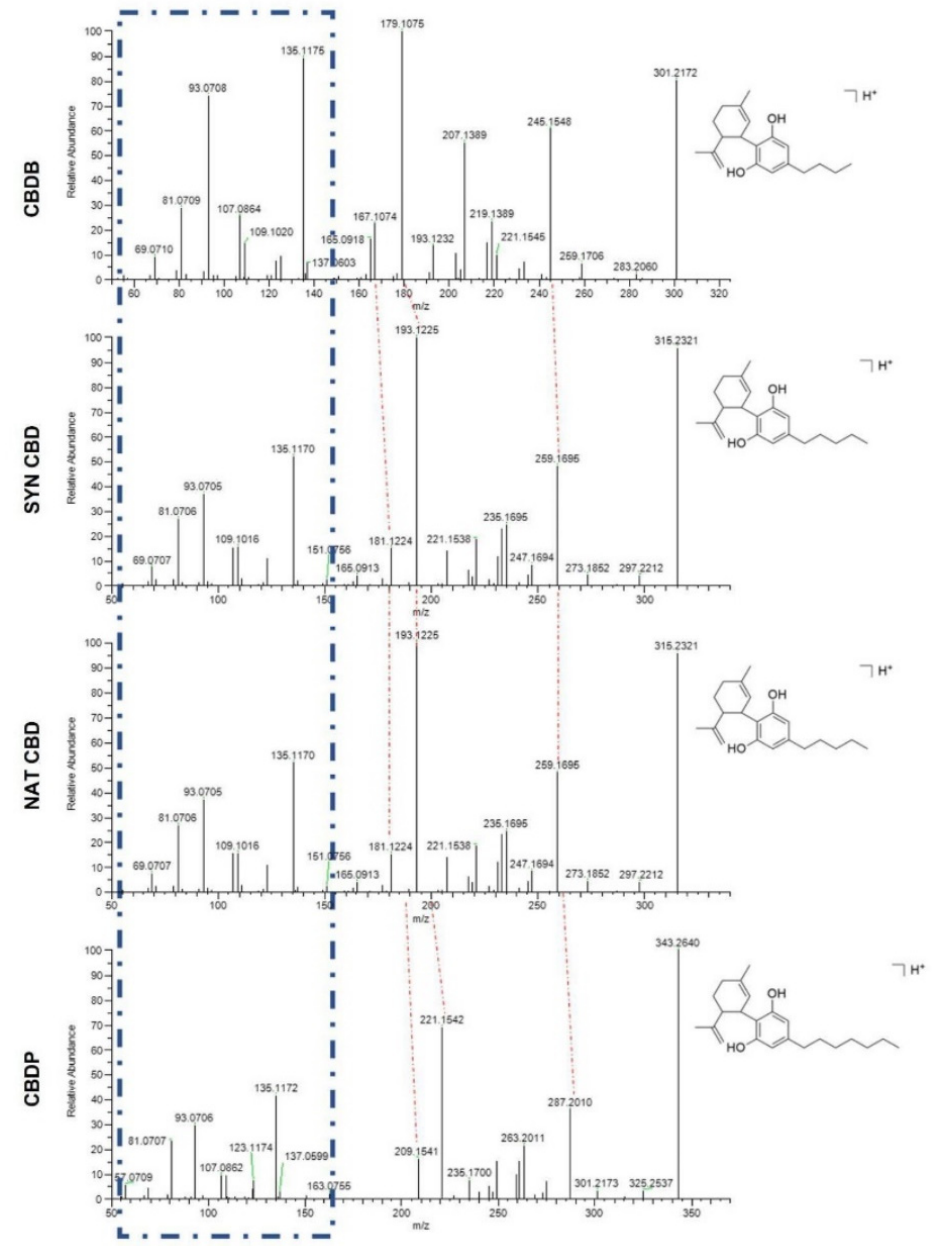
Figure 1. HPLC-HRMS analysis in positive ionization mode of the four CBD homologs under investigation. Blue dotted lines highlight the common pattern, while red dotted lines show the difference in the fragments due to the number of methylene units on the alkyl side chain.